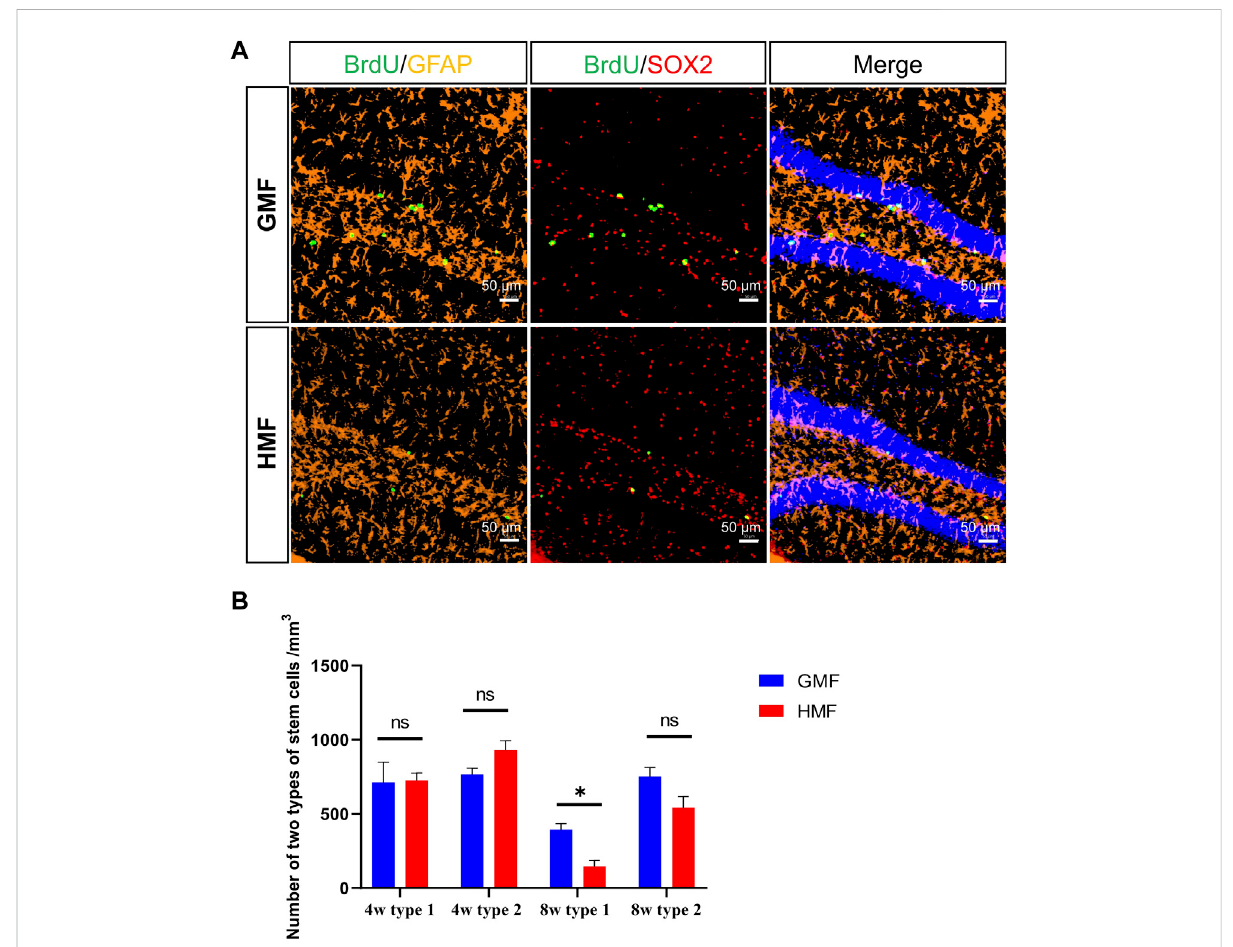
FIGURE 3 The 8-week hypomagnetic fi eld (HMF) exposure signi fi cantly decreased the proliferation of type 1 aNSCs in DG of hippocampus. (A) Representative images of BrdU + GFAP + SOX2 + cells (type 1 aNSCs) and BrdU + GFAP − SOX2 + cells (type 2 aNSCs) in the DG at 8-week GMF- or HMF- exposure. (B) Comparison of two types of aNSCs between GMF- and HMF-exposed mice ( P 8w = 0.0314). There were 4 mice in each group at each timepoint.Dataareexpressedasmean±SEM.nsmeansnosigni fi cance.* p < 0.05.GMFmeansgeomagnetic fi eld.4wmeans4-weekmagnetic fi elds exposure; 8w means 8-week magnetic fi elds